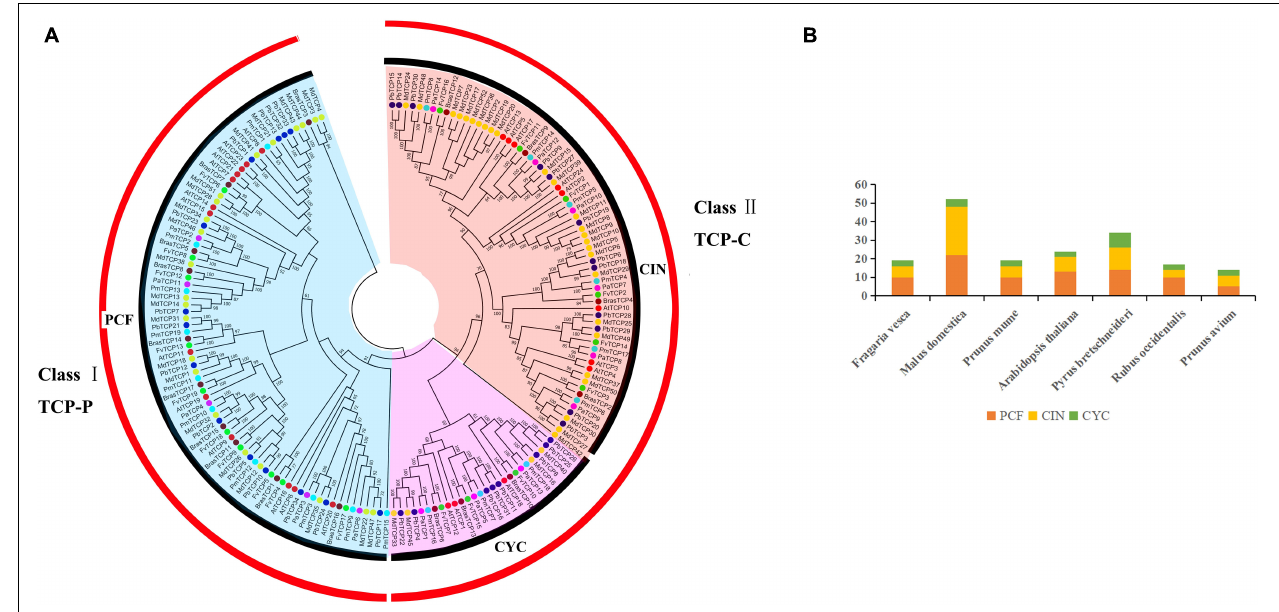
FIGURE 1 | Phylogenetic relationships and subfamily designations in TCP proteins from Pyrus bretschneideri , Fragaria vesca , Prunus mume , Rubus occidentalis , Prunus avium , Malus domestica , and Arabidopsis thaliana . (A) Interspecific phylogenetic tree of TCP protein sequences from 7 species. (B) Number of genes in each subfamily of 7